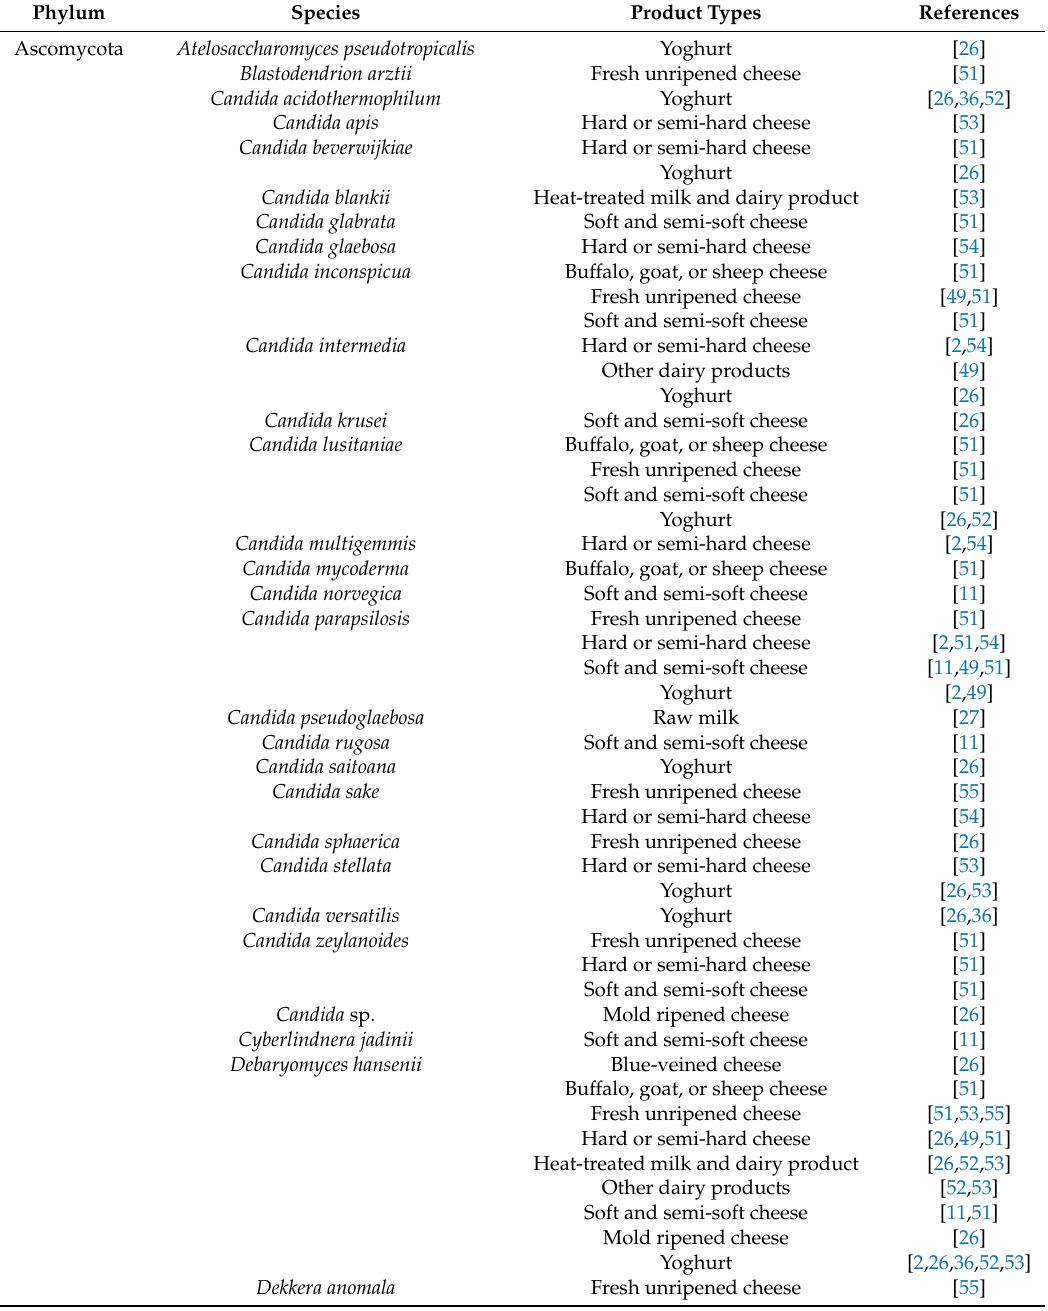
Table 1. Diversity of spoilage yeasts in dairy